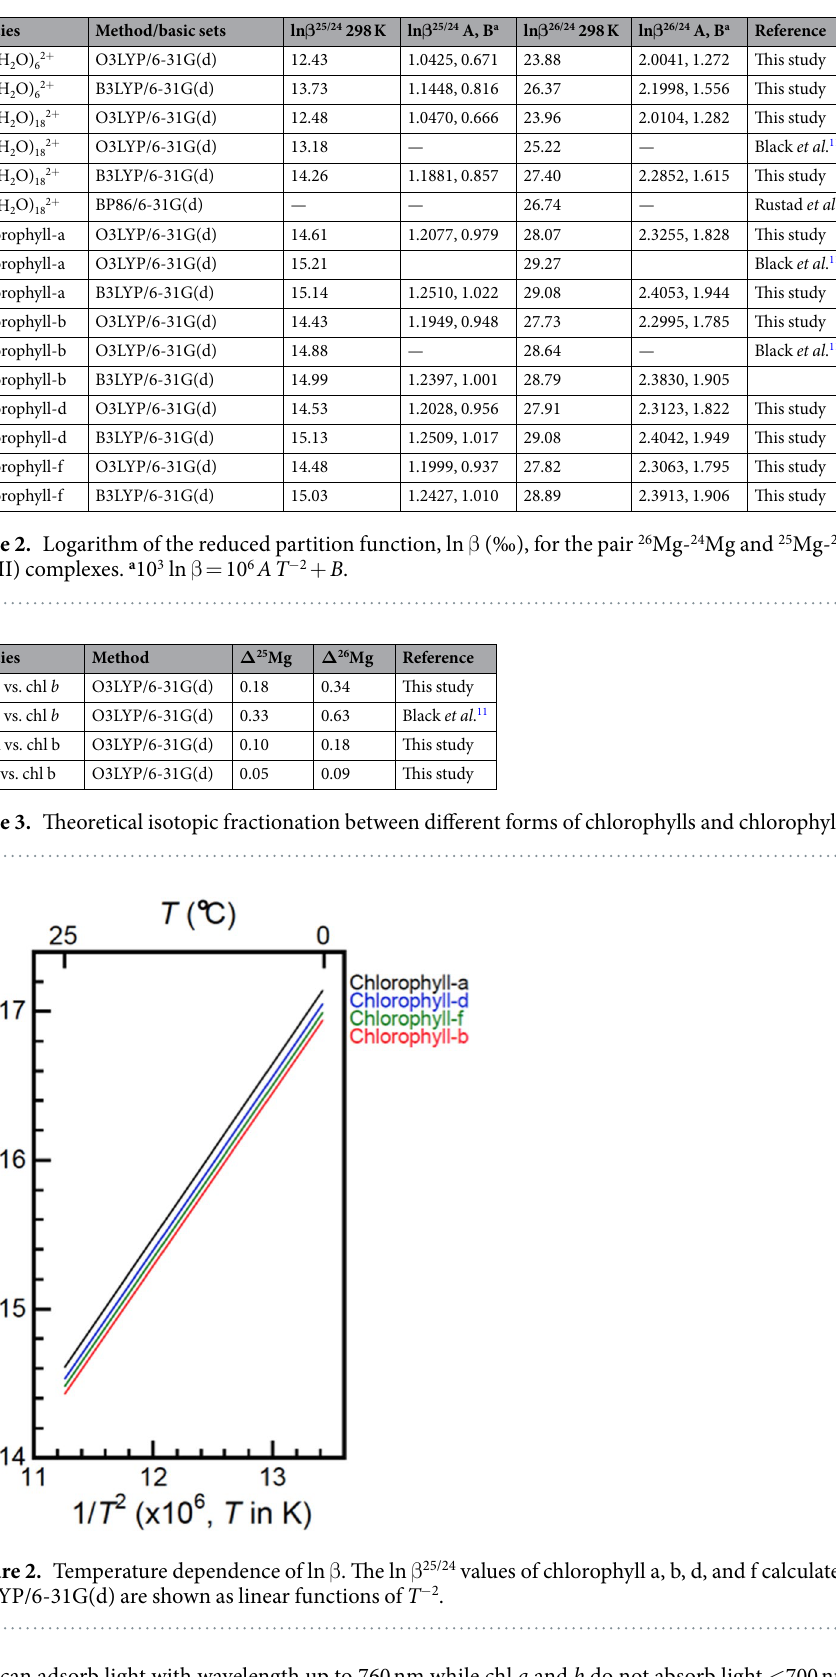
that can adsorb light with wavelength up to 760 nm while chl a and b do not absorb light < 700 nm. These pig- ments have only been discovered in a limited set of organisms so far (e.g. Acaryochloris Marina , Halomicronema Hongdechloris ) and are supposed to represent the consequence of adaptation of the micro-organisms to specific